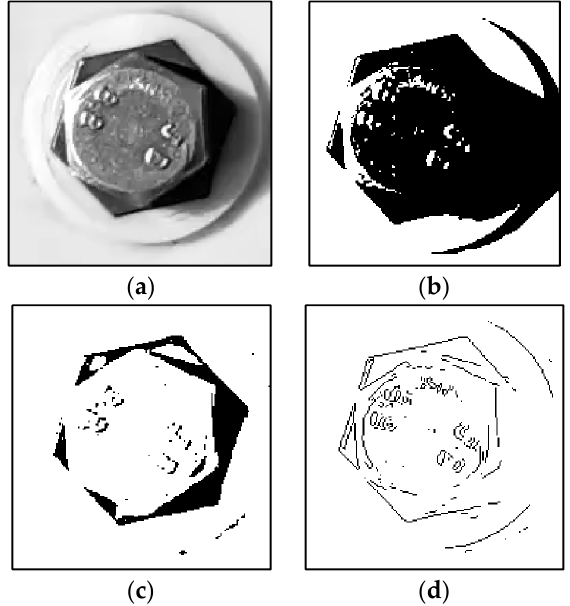
Figure 4. ( a ) Original grayscale: Grayscale conversion of the first frame of the video (Figure 3a) using luminance [50]; ( b ) Otsu threshold: Comparison of Otsu’s thresholding [51]; ( c ) Adaptive thresholding (Bradley) [52,53] with sensitivity: 0,99; ( d ) Not-Sobel filtering [54,55] applied to the grayscale image in (a).